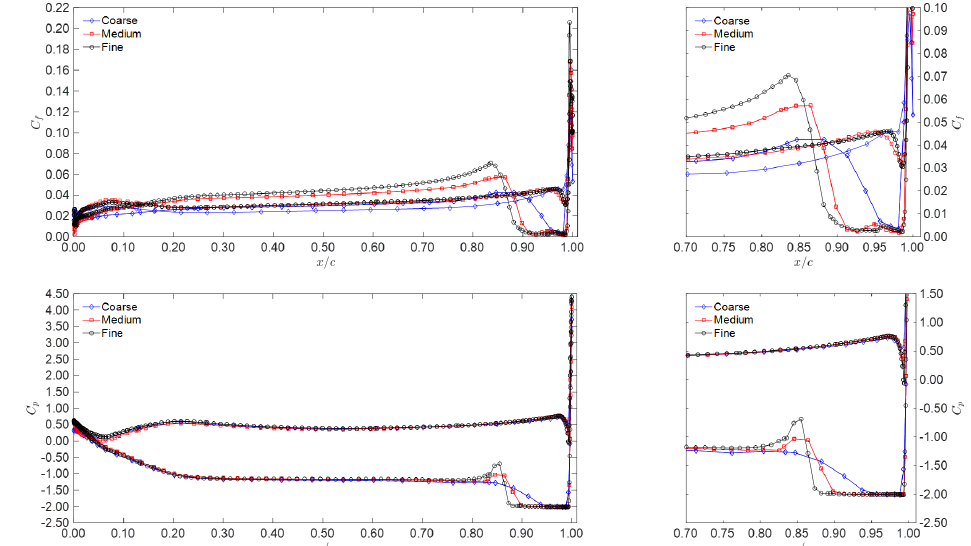
Figure 15. Comparison of skin-friction and pressure coefficient distributions at the radius r / R = 0.7 on the blades. PPTC Case 1 conditions in model scale. The results are from the three grid densities. The TE is at x / c = 0 and the LE at x / c = 1.